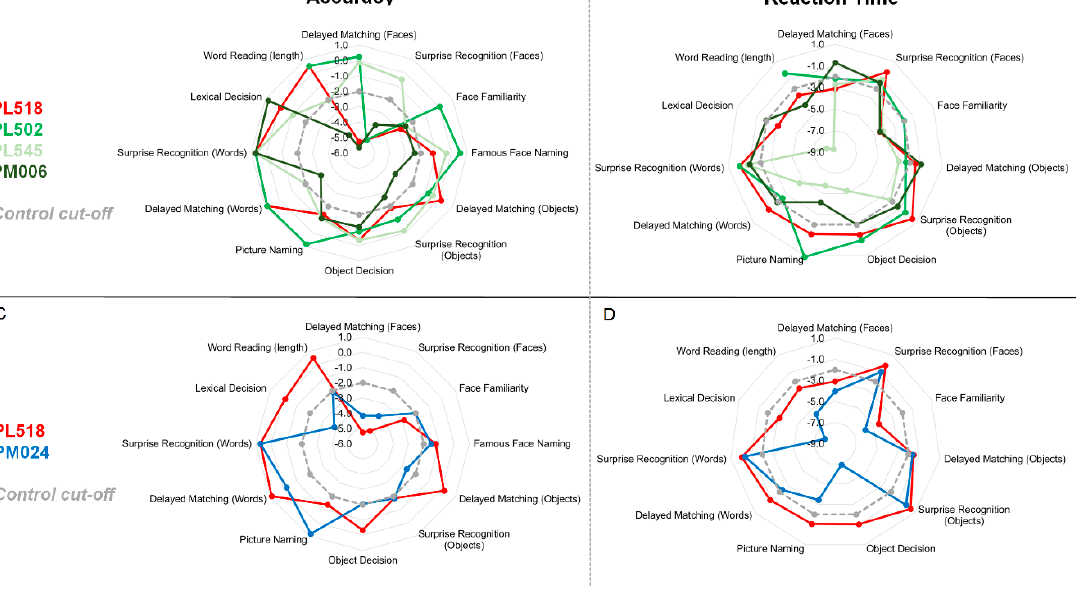
Figure 2. Radar plots showing the results of PL518 (in red) and the other patients on all the included measures of object, word, and face recognition. Numbers denote z-scores based on the control means and SDs for the respective tests. Impaired performance ( > − 2 SDs from the control mean) is marked by the dotted grey line, and scores closer to the center are more impaired (represents lower accuracy and slower RTs). Left panel ( A , C ) shows accuracy, right panel ( B , D ) shows RTs. Upper panel ( A , B ) shows PL518 vs. PM024 (architect with right hemisphere lesion). Lower panel ( C , D ) shows PL518 vs. the other bilateral patients. See individual radar plots comparing PL518 individually to bilateral patients in Figure S1.